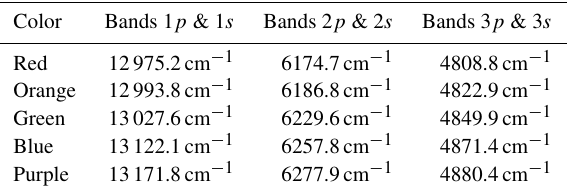
Table 5. Wavenumbers considered for the radiometric performance